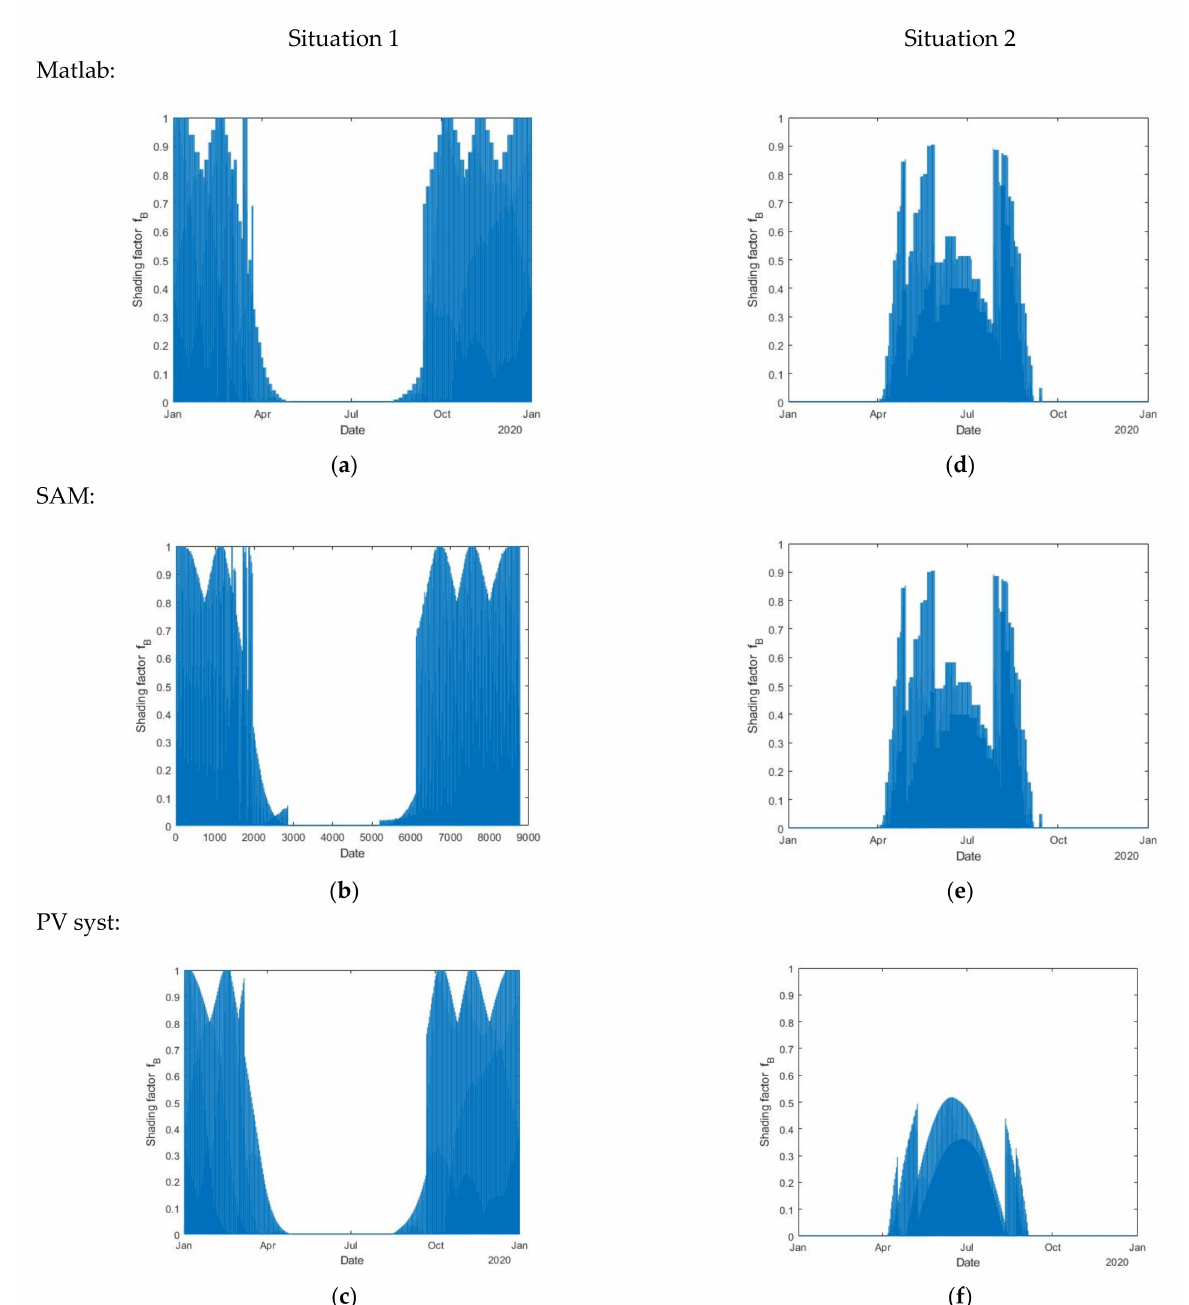
Figure 18. Shading factors f B for a complete year. Results for situation 1 obtained with: ( a ) Matlab; ( b ) SAM and ( c ) PVsyst. Results for situation 2 obtained with ( d ) Matlab; ( e ) SAM and ( f )